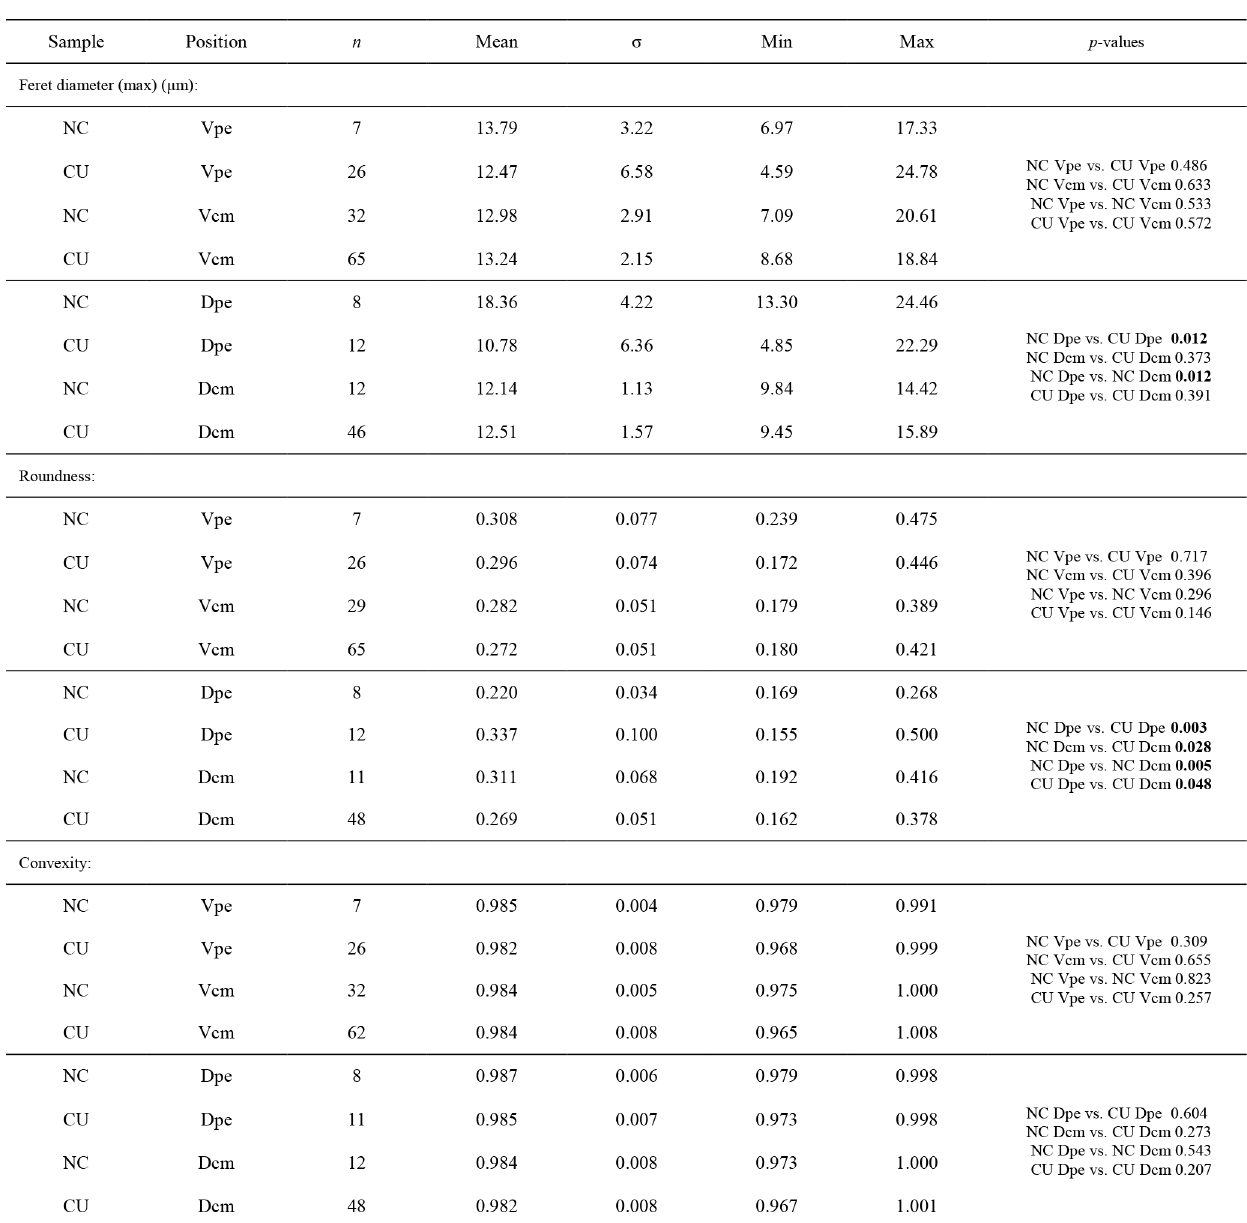
Table 8. Statistical comparison of fibre size and shape of the posterior external vs. central middle parts of the ventral and dorsal valves. NC: non-cultured samples no. 158 and no. 223; CU: cultured samples nos. 43, 63, 8005, and 9006; Vpe: ventral posterior external, Vcm: